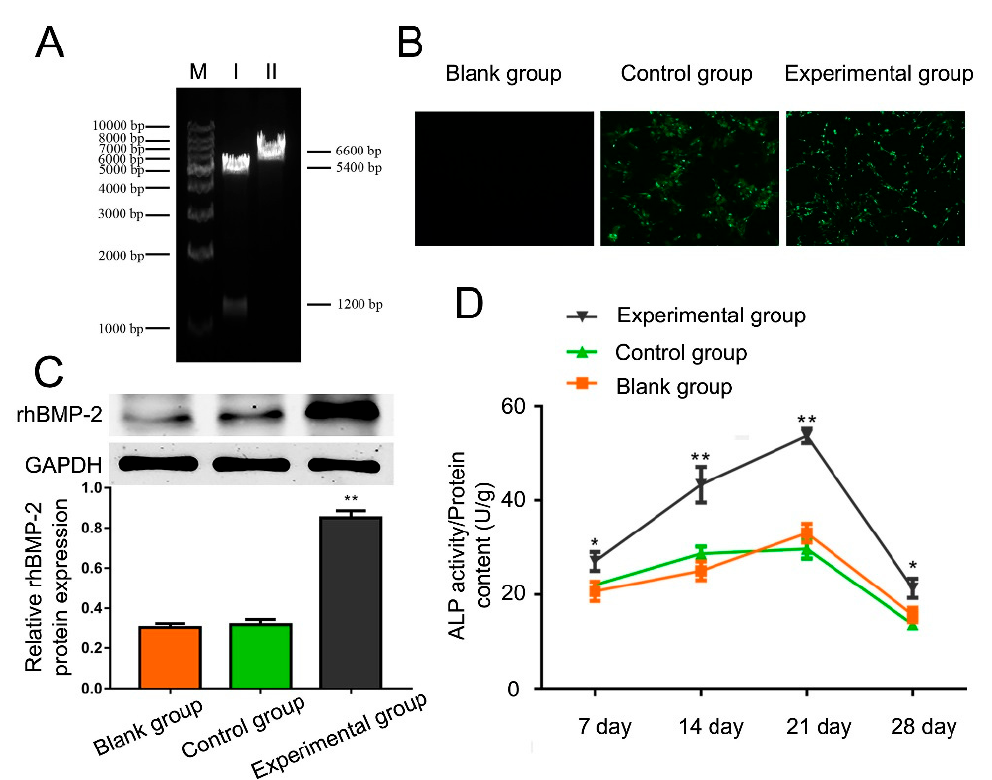
Figure 2. ( A ) Recombinant plasmid pcDNA3.1-rhBMP-2 electrophoresis. M: DNA ladder marker with